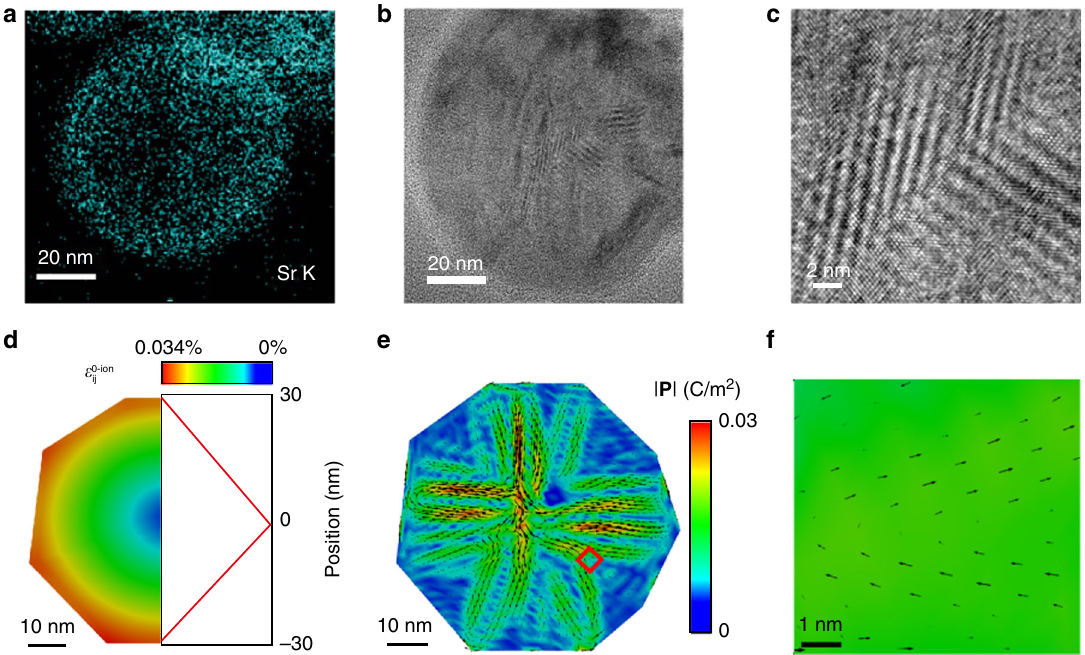
Fig. 3 Experiment and simulation of domain-like nanoregions (DLNRs). a Energy-dispersive X-ray spectroscopy elemental map showing the Sr 2 + distribution. b , c Transmission electron microscopy (TEM) image of the core – shell nanoparticle and the enlargement of the red box region in b . d The linear distribution of the eigenstrain along the radius direction according to a . The symbol ε 0 (cid:1) ion stands for the eigenstrain due to the strontium inhomogeneity ij through the Vegard effect. e Flexoelectric-ferroelectric phase fi eld simulation results of the polarization for the whole nanoparticle, experimentally shown in b The symbol | P | represents the magnitude of the polarization. f The enlargement of the red box region in e showing similar DLNRs as observed in the TEM images of